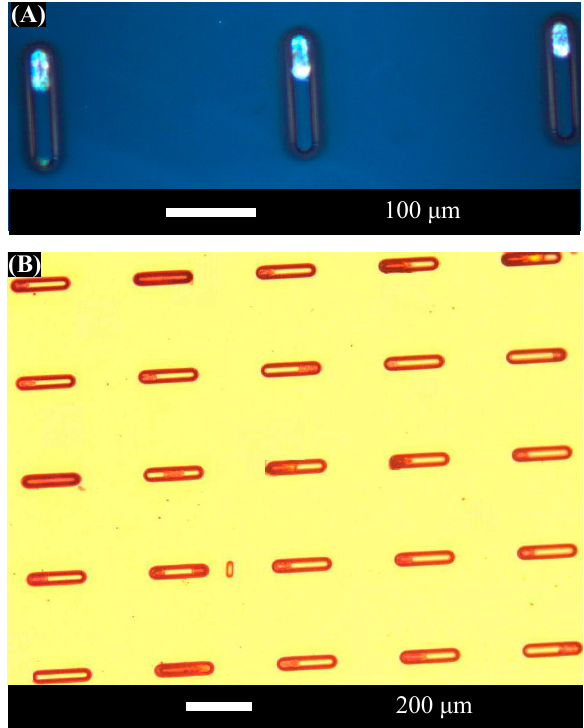
Figure 6. Optical micrographs showing portions of the assembly template after assembly of cylindrical components. ( A ) shows a higher magnification view of assembly into wells 120 μ m in length. ( B ) shows a lower magnification view of assembly into a large number of wells 200 μ m in length. Variations in well appearance after assembly reflect where components are located in the wells and how many components are assembled in each well.